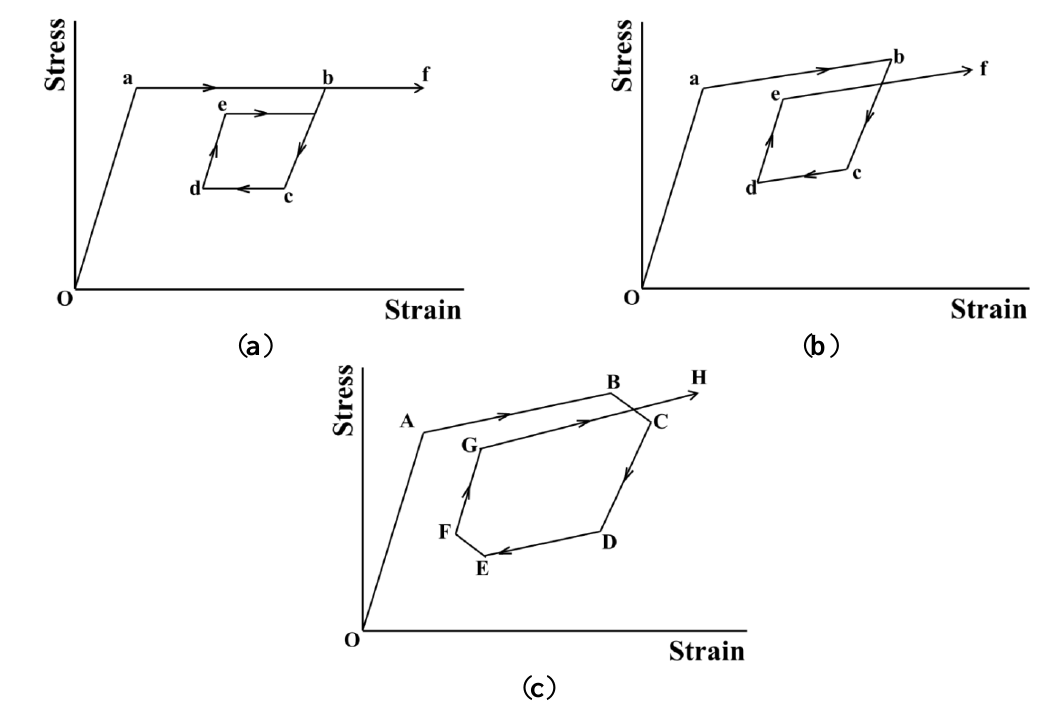
Figure 1. Stress-strain diagrams in superelasticity (SE) subloop strain-controlled and stress-controlled loadings under various loading rates. ( a ) Constant low strain rate; ( b ) Constant high strain rate; ( c ) Constant stress